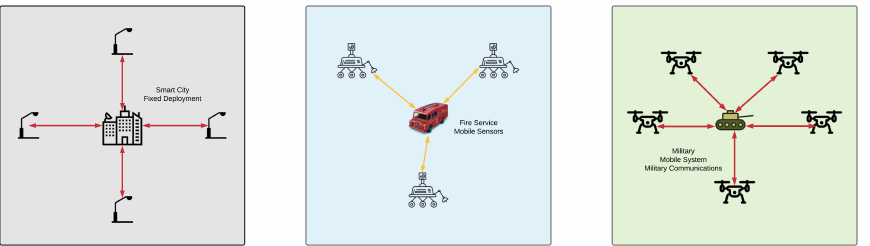
Figure 1. An example of three IoT-based sensor systems, which may be required to operate together in an emergency